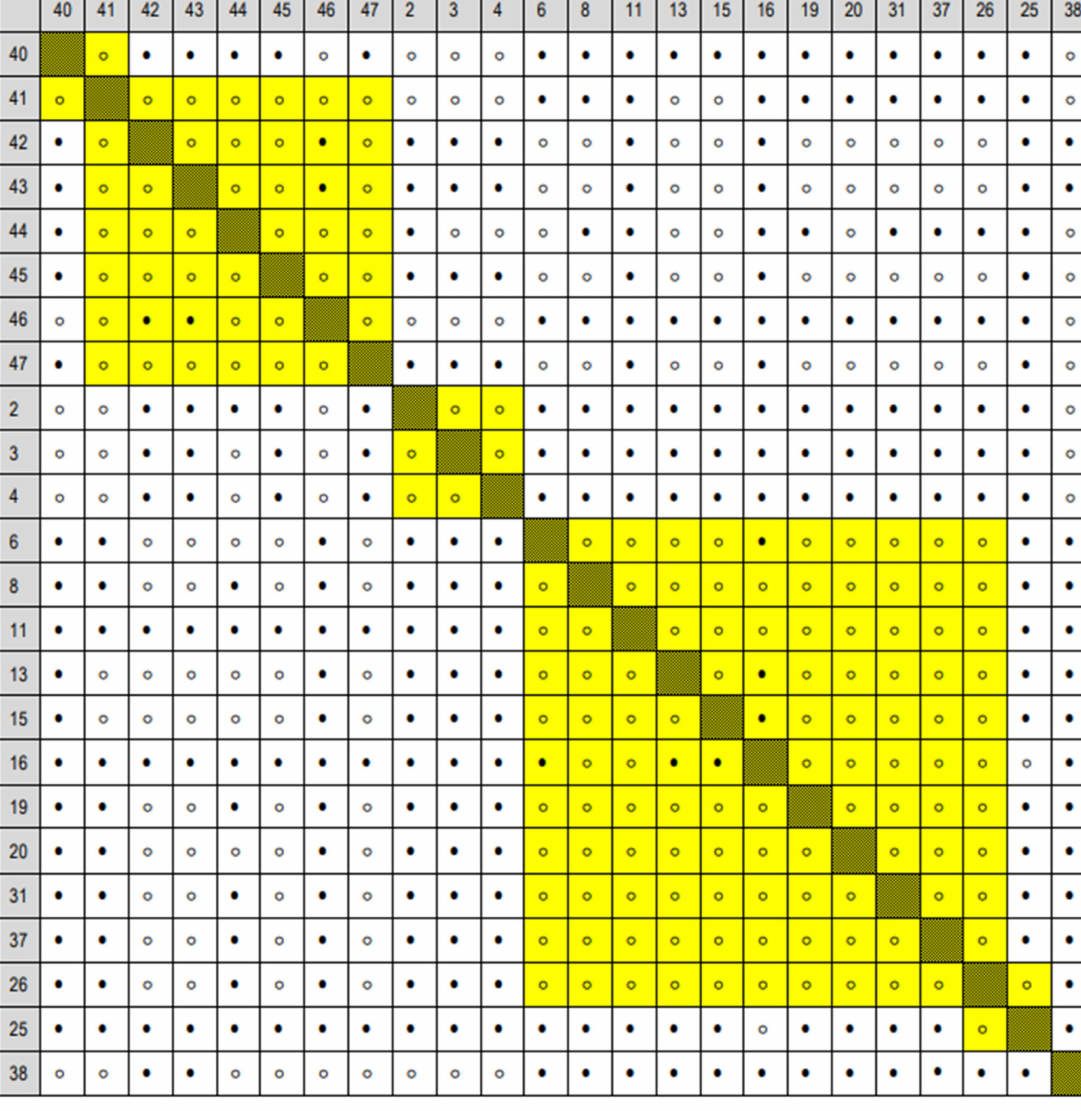
Figure A5. Matrix of significance of population mean height differences of the trial Zbiroh, sorted by their geographic position from NW to SE (the first three digits of the reg. numbers are